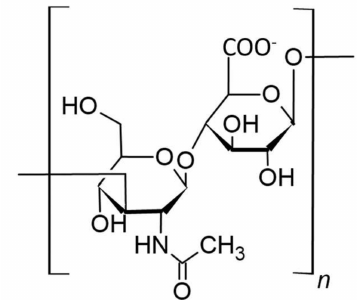
Figure 9. Chemical structure of hyaluronic